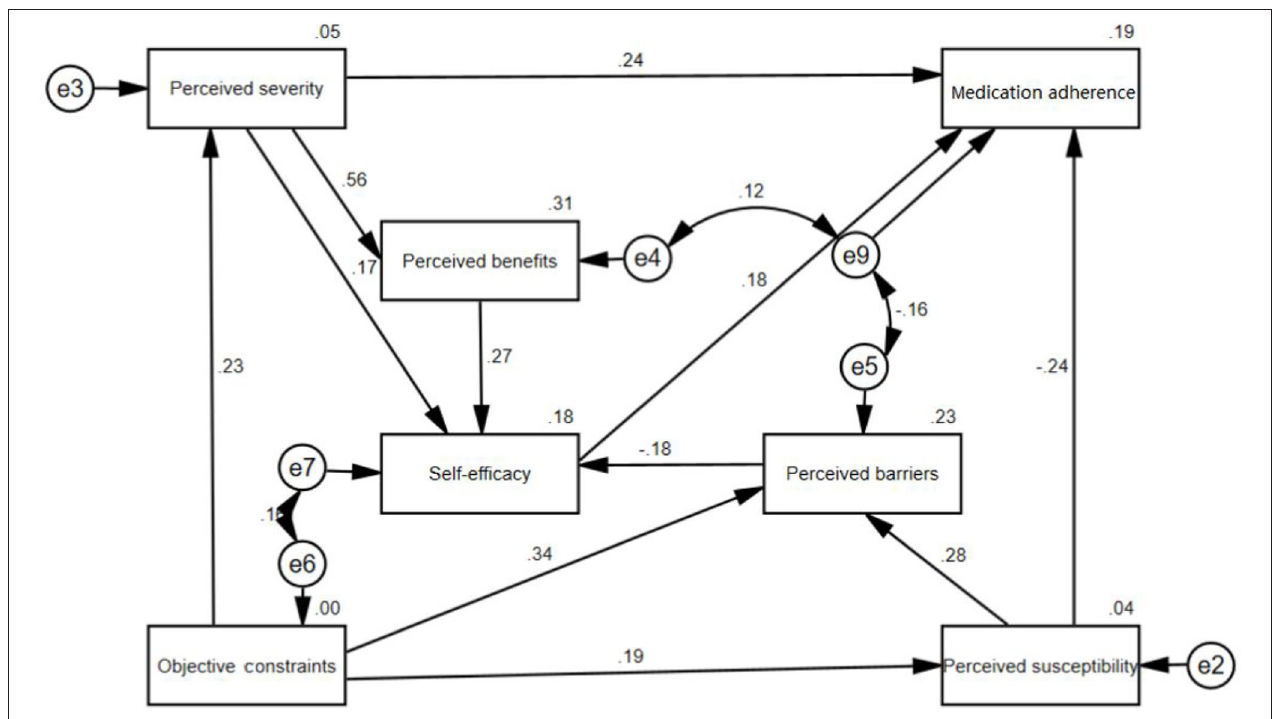
FIGURE 3 | Structural equation model of parents’ health belief on their children’s medication adherence. The value on the one-way arrow is the coefficient in the structural equation model, indicating the magnitude of the former’s influence on the latter. If the value on the one-way arrow is positive, it means that the former has a positive influence on the latter. If the value on the one-way arrow is negative, it means that the former has a negative influence on the latter. e2, e3, e4, e5, e6, e7, e8, and e9 are residual items, representing confounding factors independent of the established structural equation model.